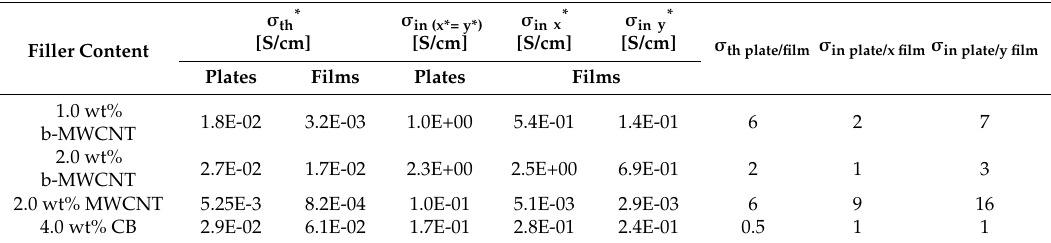
Table 4. Comparison of the electrical conductivity of PVDF/carbon filler composites shaped into plates and extruded films and conductivity quotients σ plate/film in x = y (for plates) or x, y (for films) and z (through-plane)